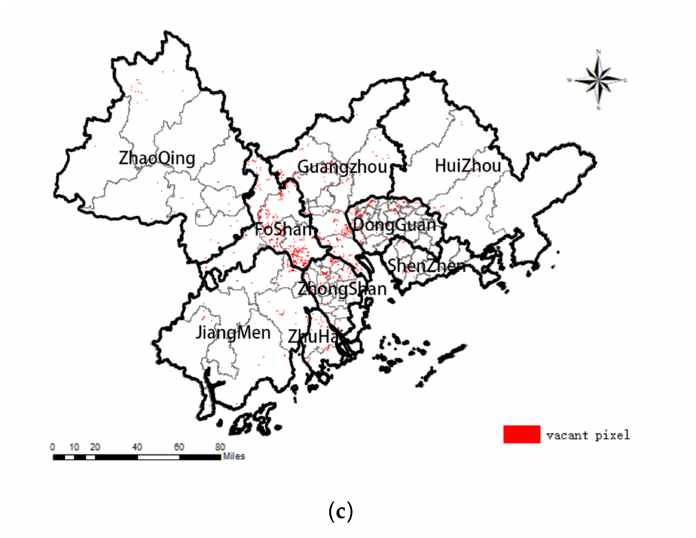
Figure 10. Spatial distribution of vacant pixels in the PRD. ( a ) 2013, ( b ) 2016, ( c ) 2019. Table 5. Number of vacant pixels in cities in the